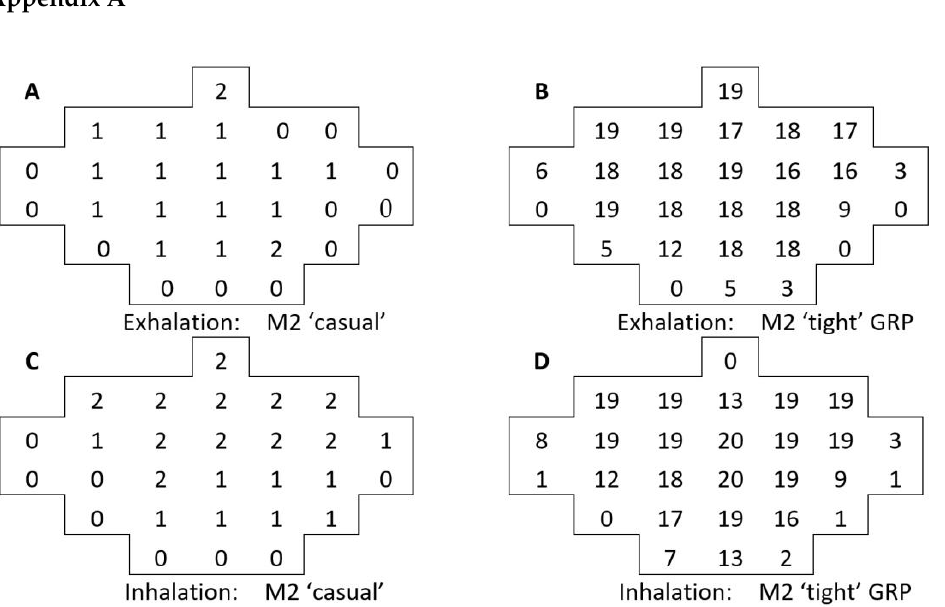
Figure A1. Measured pressure (Pa) under mask at 28 locations for mask M2 at steady respiration flow of Q = 10 L min −1 . ( A , B ): exhalation ‘casual’ (96% leakage) and ‘tight’ GRP fitter (30% leakage). ( C , D ): inhalation ‘casual’ (94% leakage) and ‘tight’ GRP fitter (29% leakage). Shown values of pressure are positive for exhalation and negative for inhalation.